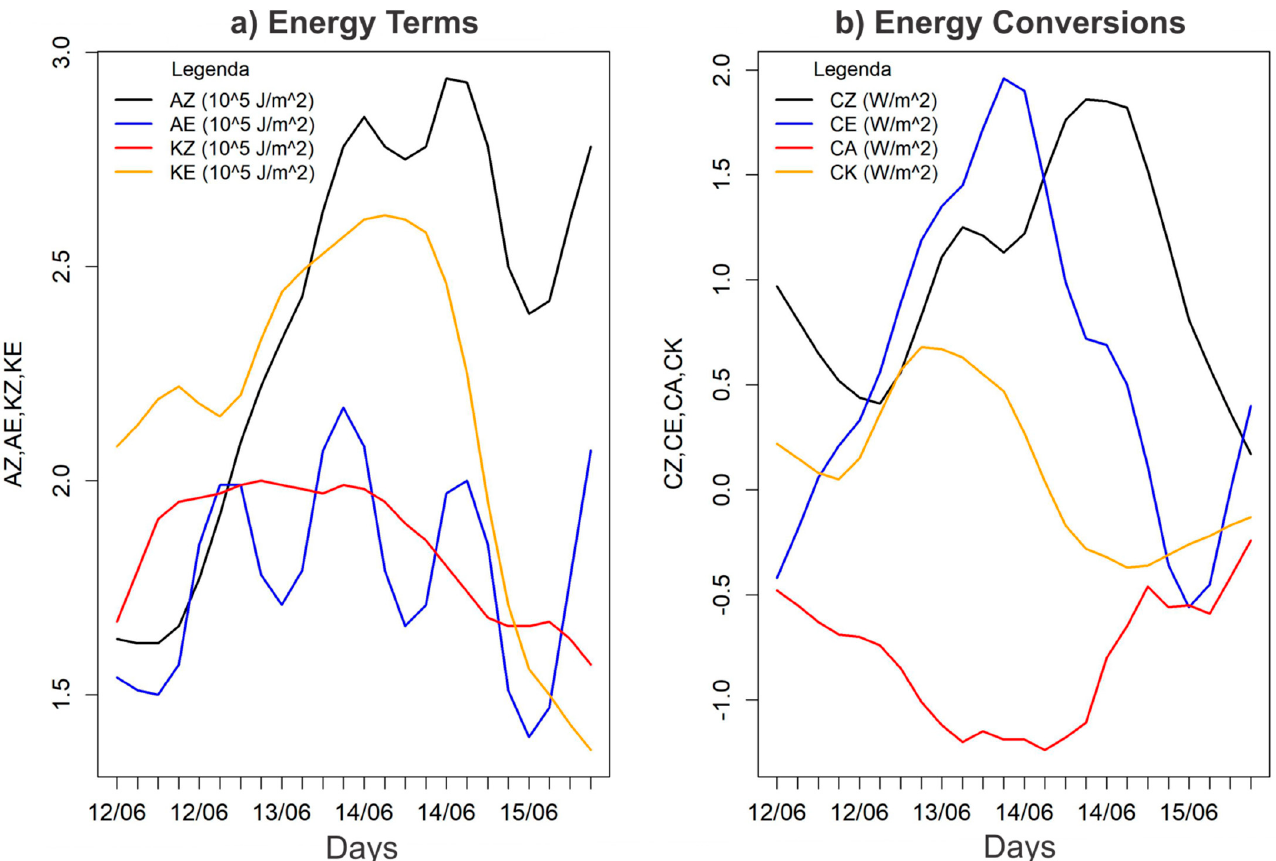
Figure 7. Variations and conversions of energy terms between 12 and 15 June 2014 in the region comprising the continental and oceanic parts of the east coast of Northeast Brazil affected by the EWD.